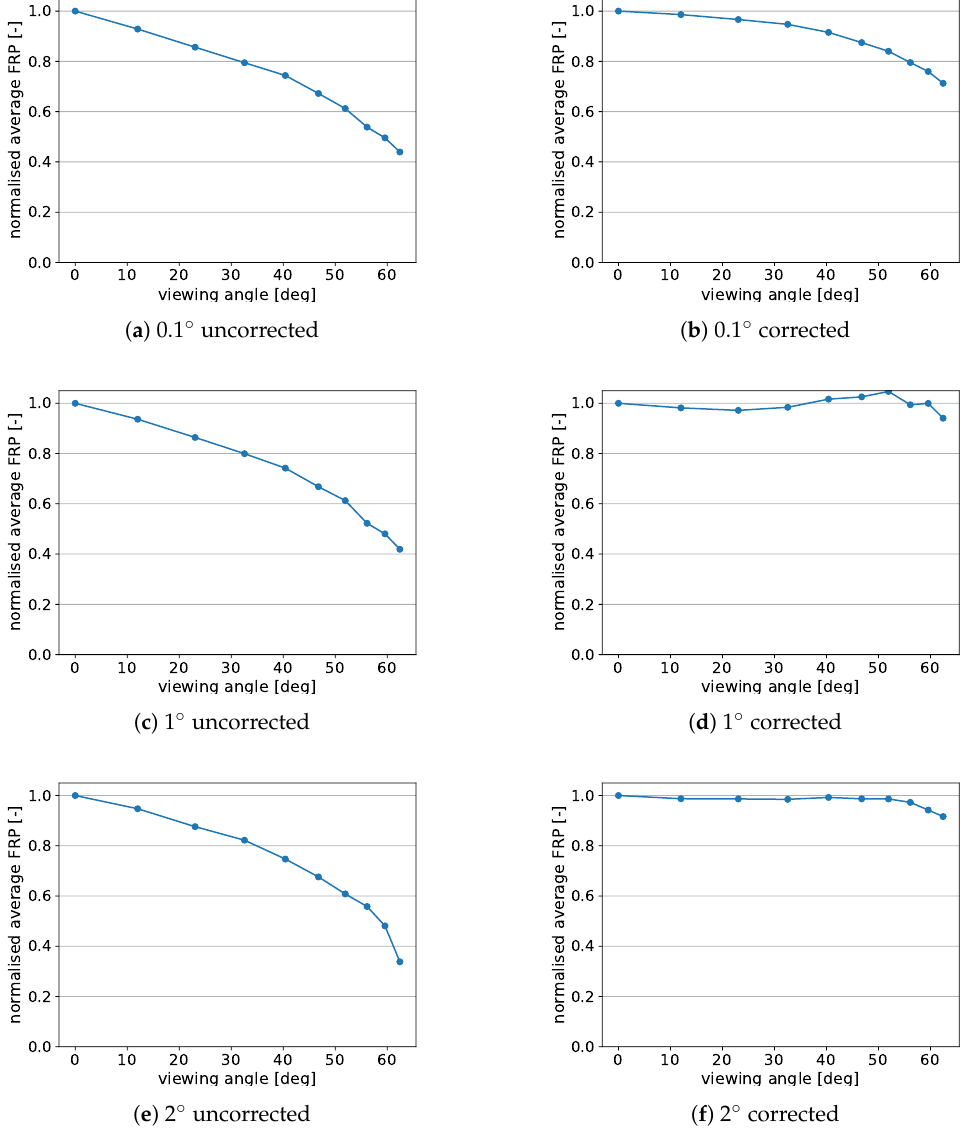
Figure 2. ( a , c , e ): The uncorrected normalised average gridded-FRP (from control data, year 2016) in each viewing angle bin for 0.1 ◦ , 1 ◦ , and 2 ◦ spatial resolution. ( b , d , f ): The corrected normalised average gridded-FRP in each viewing angle bin for 0.1 ◦ , 1 ◦ , and 2 ◦ grid-level, respectively. The average gridded-FRP in each viewing angle bin is calculated according to Equation